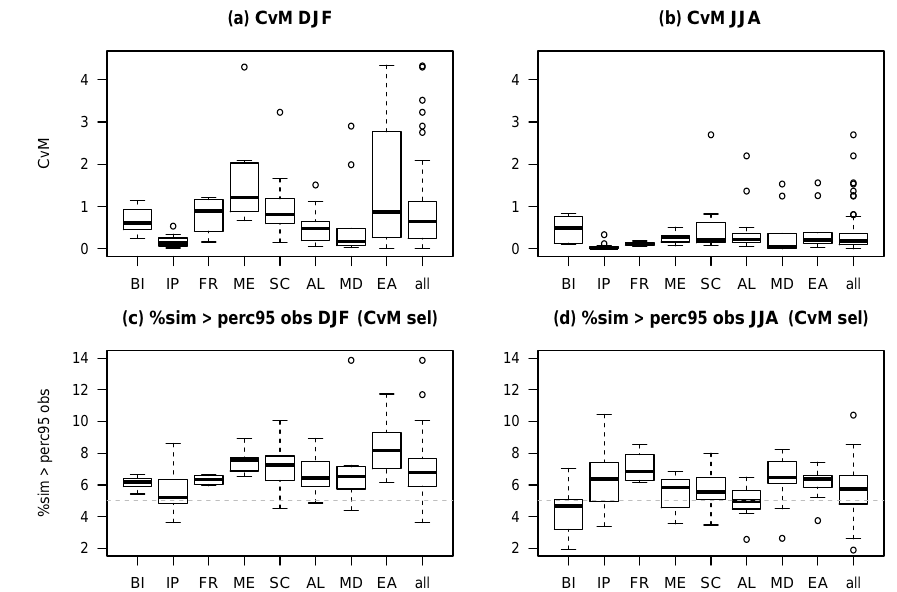
Figure 5. Step 1: bias correction to grid scale. Boxplots of (a, b) CvM score and (c, d) percentage of simulated wet days exceeding the observed 95th percentile (%sim > perc95 obs ) for the CvM-selected cross-validated predictor in European subdomains: British Isles (BI), Iberian Peninsula (IP), France (FR), Mid-Europe (ME), Scandinavia (SC), Alps (AL), Mediterranean (MD), and eastern Europe (EA). Outlier out of range in (b) AL and all: